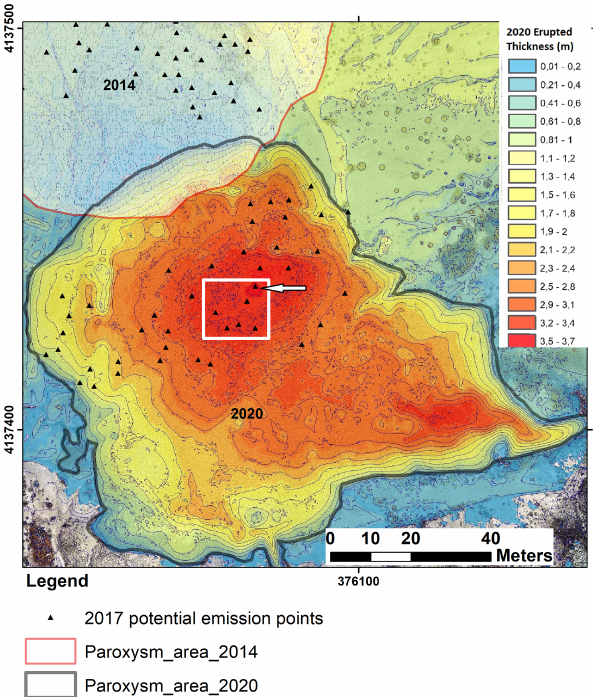
Figure 8. The 2020 thickness map for the erupted materials, due to the paroxysm event of 19 May. Inside the white square is the emission point detected in 2017, corresponding to the main centre for the 2020 paroxysm (source: 2020 contour map in ArcGIS 10.5).